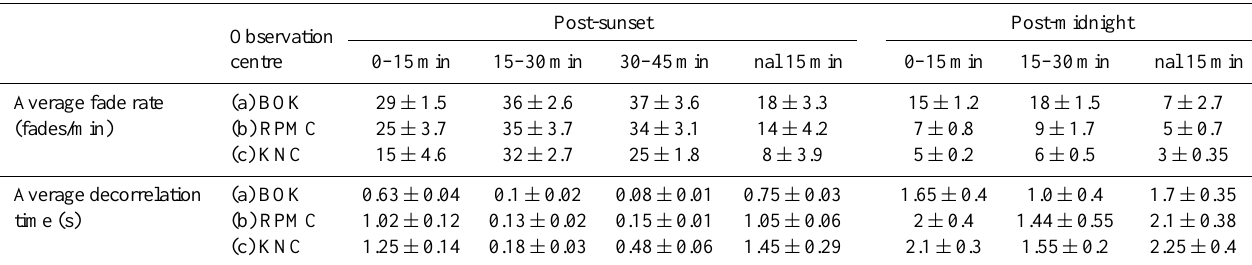
Table 1. Average values of fade rate and decorrelation time for VHF scintillation in post-sunset and post-midnight period at three centres: BOK, RPMC and KNC. Total # of scintillation days: 22 (BOK), 26 (RPMC), 25 (KNC) and 12 (BOK), 11 (RPMC), 9 (KNC) for post-sunset and post-midnight period.